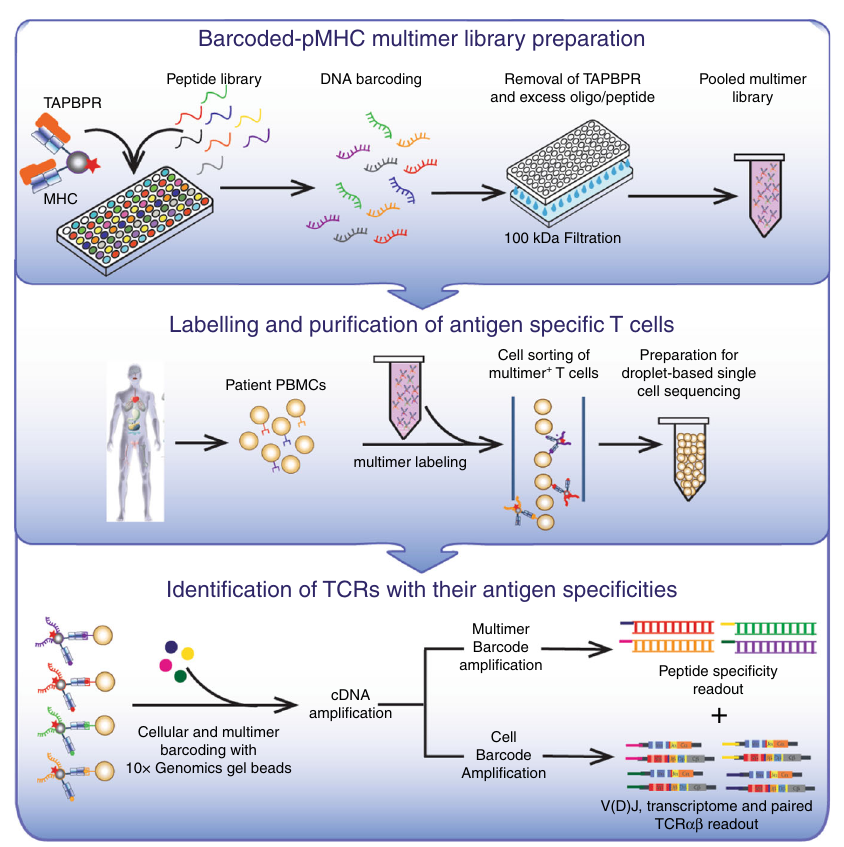
Fig. 1 Linking peptide speci fi cities with T cell transcriptomes. Fluorophore-labeled, empty MHC-I/TAPBPR multimers are loaded with peptides of interest on a 96-well plate format and individually barcoded with DNA oligos designed for 10x Genomics and Illumina compatibility. TAPBPR and excess peptide, along with free oligo, are removed by centrifugation and the multimers are pooled together. A single patient sample can be stained with the pooled multimer library, and collected by fl uorescence-activated cell sorting. Tetramer associated oligos and cellular mRNA from individual cells are then barcoded using 10x Genomics gel beads, followed by cDNA synthesis, library preparation and library sequencing. This work fl ow enables the transcriptome and paired αβ TCR sequences to be linked with pMHC speci fi cities in a single